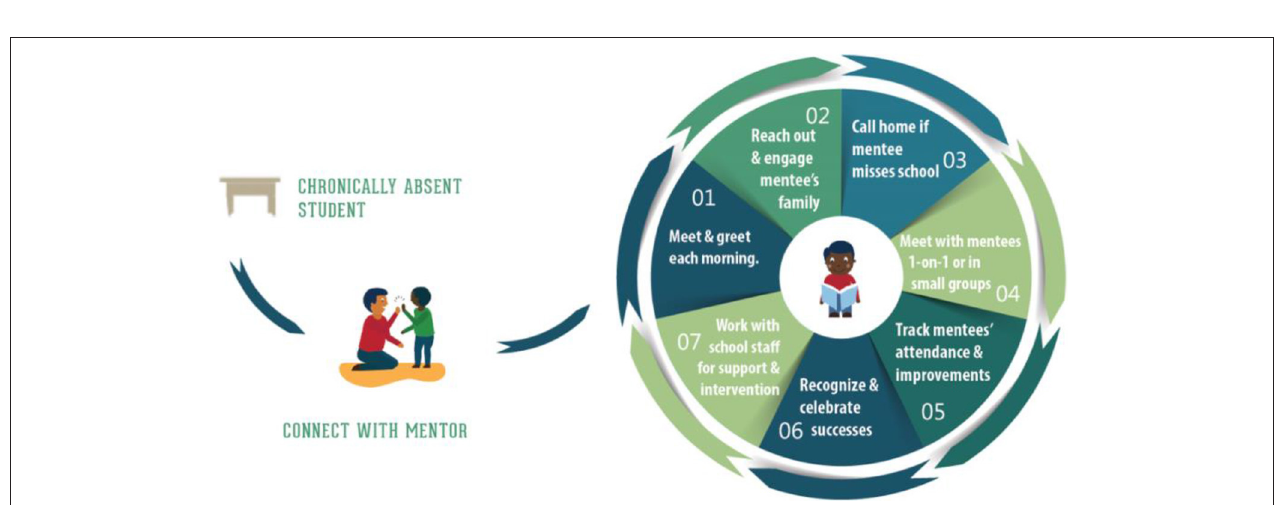
FIGURE 2 | Key elements of a CORE success mentor (Used with permission from Attendance